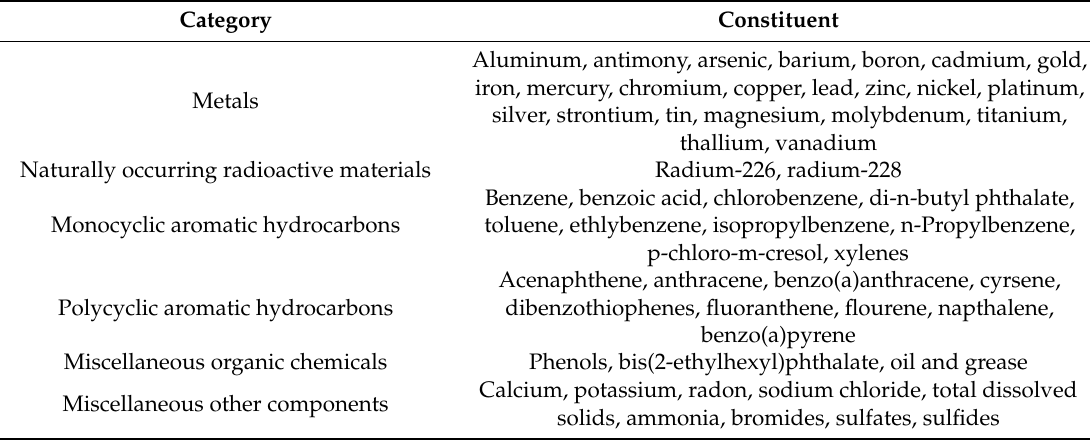
Table 2. Common components of produced water resulting from oil and gas production